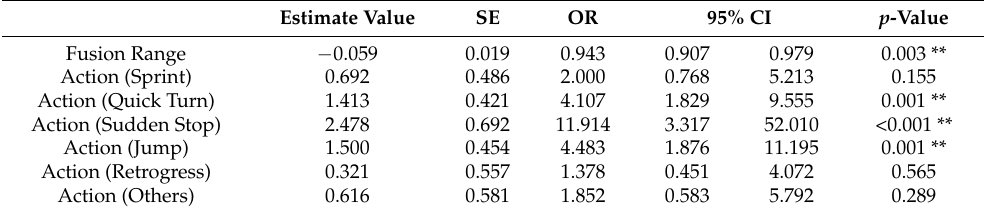
Table 7. Results of multivariate logistic regression analysis of combined data.